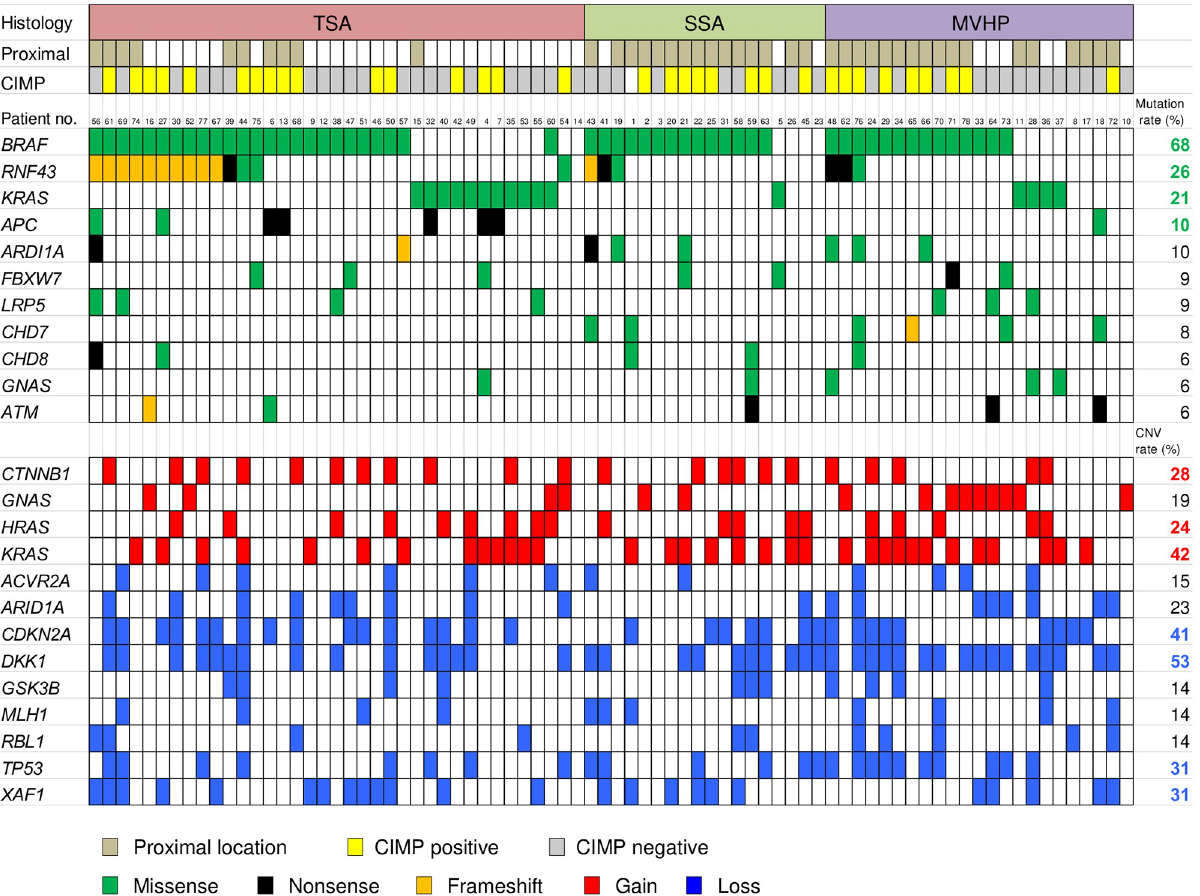
Fig 1. Summary of somatic mutations and CNVs across 78 serrated lesions. Profiles of gene mutations and CNVs within individual samples are grouped with respect to histological types. In the upper panel, the top row indicates the histology, the second row indicates the tumor location, and the third row indicates the CIMP status. Columns correspond to the individual cases. In the middle panels, frequently mutated genes, colored to indicate the type of mutation, and their mutational frequency are shown. In the lower panels, CNVs frequently detected in colorectal serrated lesions are shown.